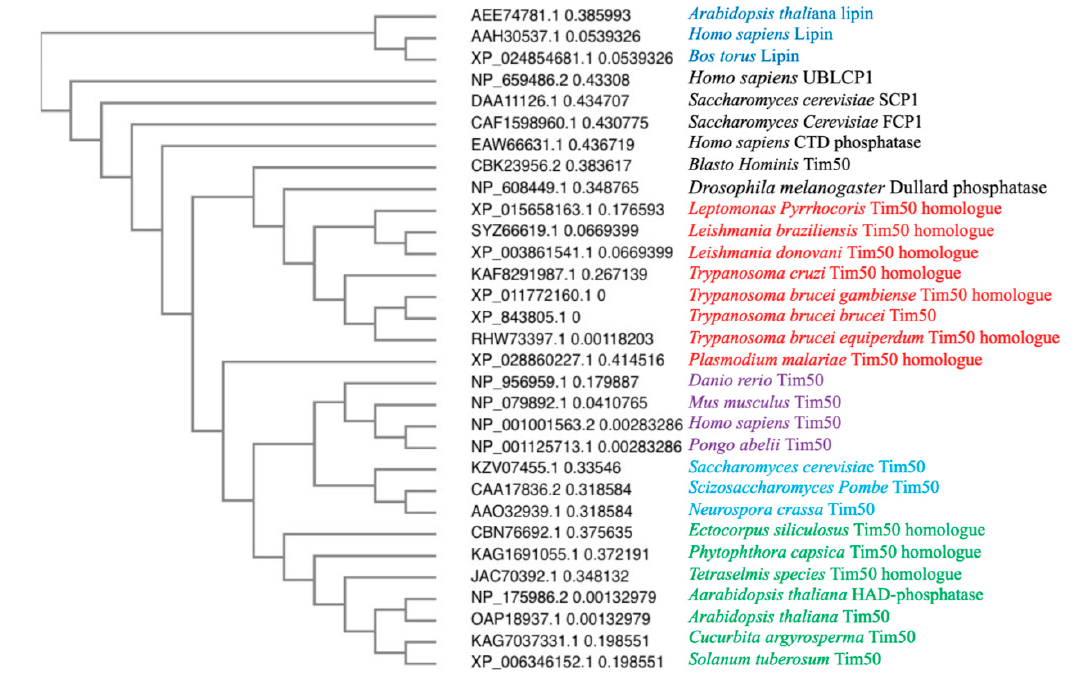
Figure 3. Phylogenetic analysis of the Tim50 homologues and few HAD-phosphatase family proteins from different organisms. Sequences were aligned in PHYLIP format and guided tree was generated using CLUSTAL Omega server. The image shows a Neighbour-joining tree without distance correction. Accession number for each protein in the NCBI protein database is indicated. Tim50s in plants (green), yeast/fungi (blue), animals (purple), and trypanosomatids (red) are indicated by different colors as indicated. Other HAD phosphatases and Lipins are shown in black and darker blue,